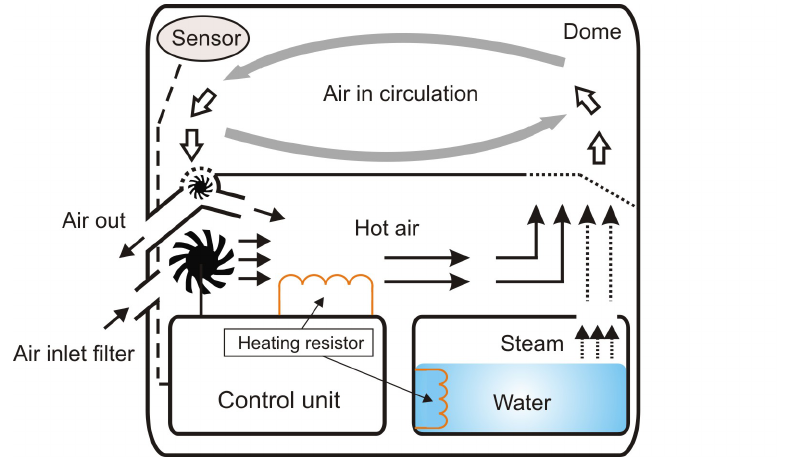
Figure 2. Overview of the incubator operation.